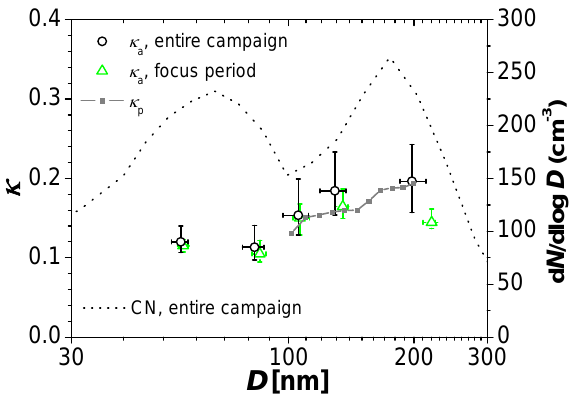
Fig. 3: Effective hygroscopicity parameters plotted against midpoint activation diameters derived from CCN efficiency spectra ( κ a and D a from 3-parameter CDF fits) averaged over the entire campaign (black circles) and over the focus period (green triangles, 6-12 March), respectively. The data points are median values corresponding to a given level of supersaturation ( S = 0.10-0.82%), and the error bars extend to from the lower to the upper quartiles. Gray squares and line indicate the effective hygroscopicity parameters predicted from campaign median organic and inorganic mass fractions determined by size-resolved AMS measurements ( κ p ). Dotted line shows the median number size distribution of total aerosol particles (CN) averaged over the entire campaign.